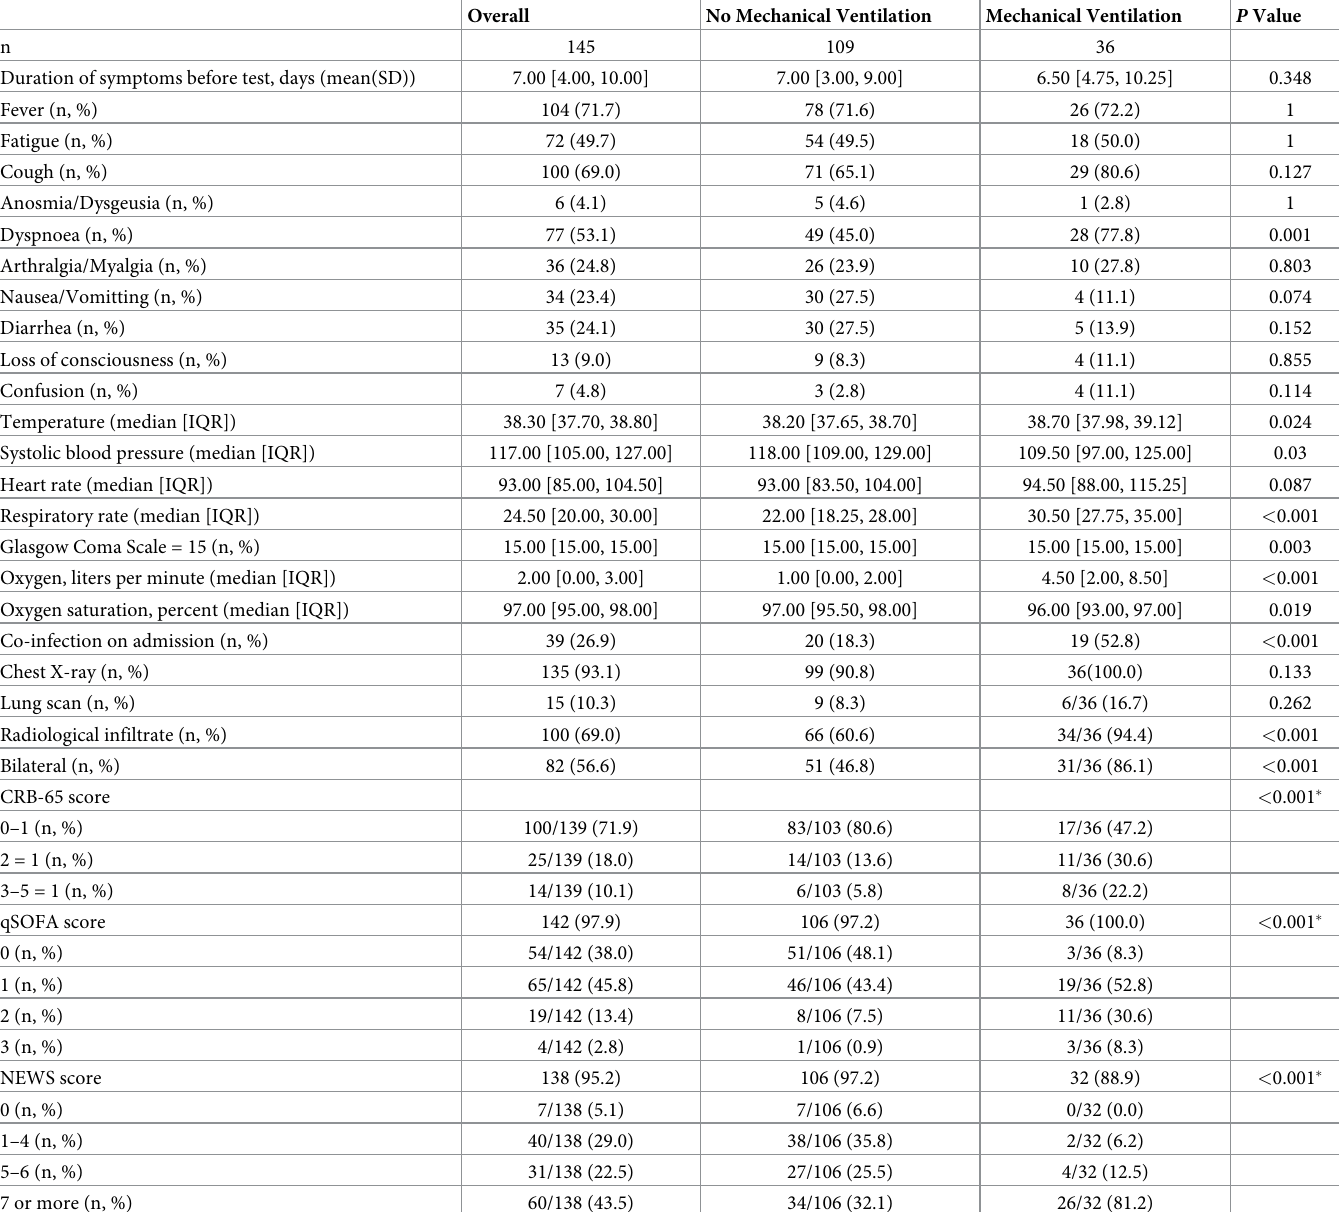
Table 3. Clinical characteristics and radiology of patients on admission.